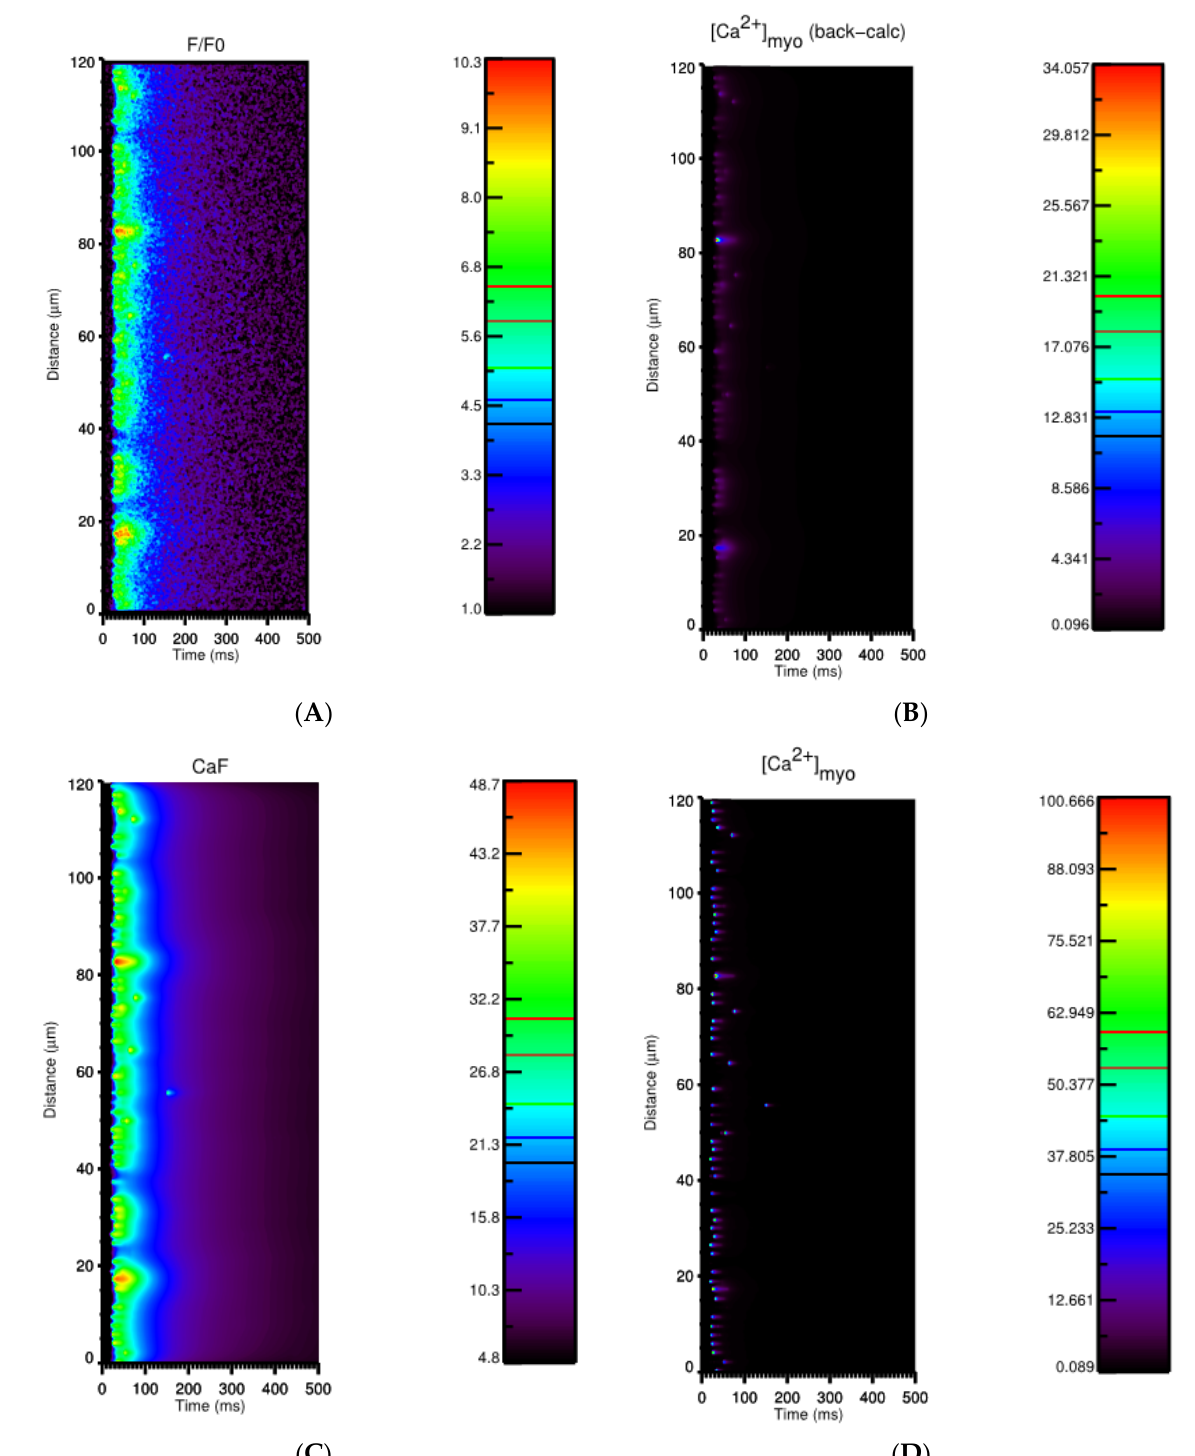
Figure 4. Using the simulation data, a multitude of information can be extracted. Apart from a snapshot of a pseudo-line scan calcium transient during Ca 2+ transient along the longitudinal direction, as shown in ( A ), we are able to show ( B ) the dynamics of free calcium content, ( C ) the dynamics of calcium-bound fluorescent, ( D ) the dynamics of total calcium content.